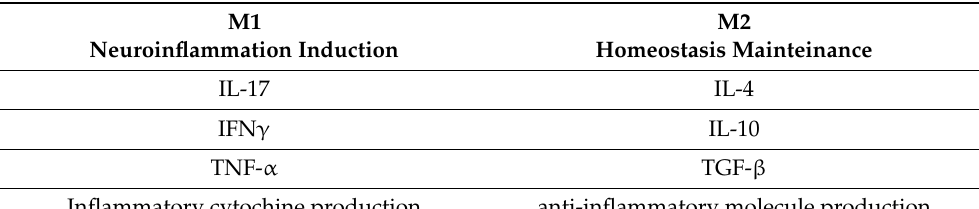
Table 3. Factors regulating M1/M2 microglia switching. Pro-inflammatory (Il-17, IFN γ , TNF- α ) and anti-inflammatory (IL-4, IL-10, TGF- β )